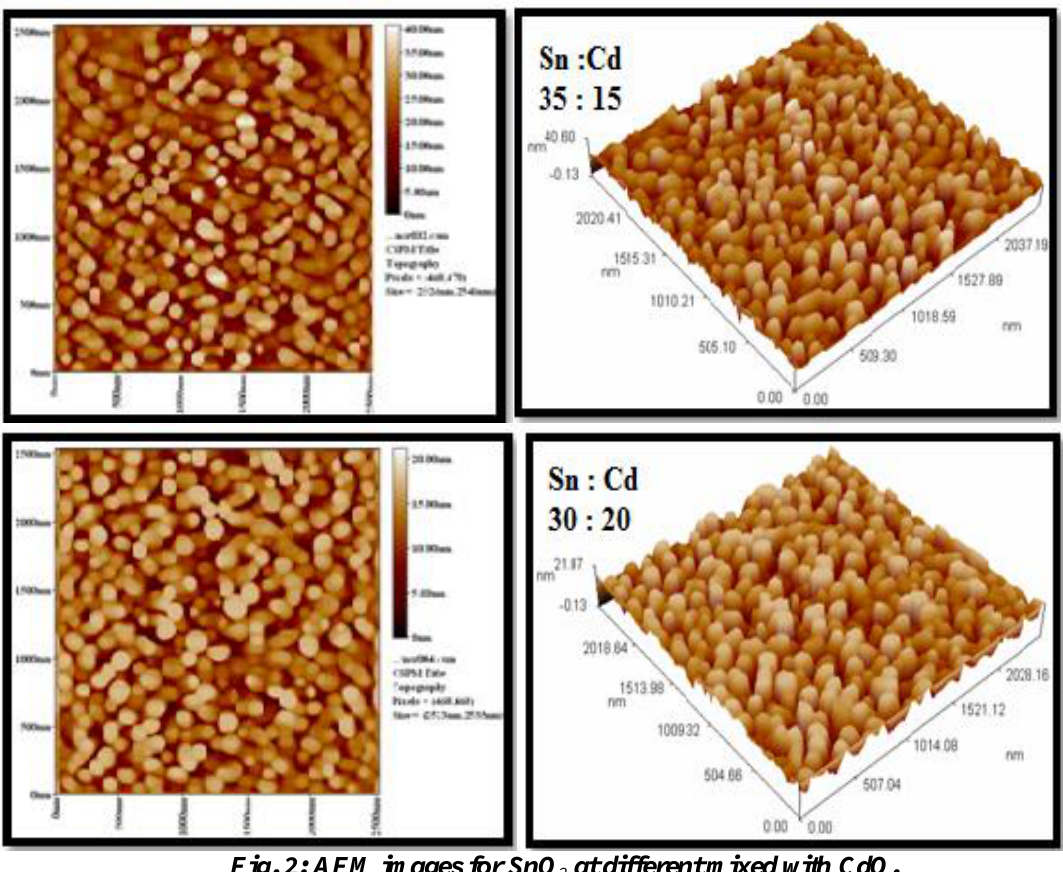
Fig. 2: AFM images for SnO